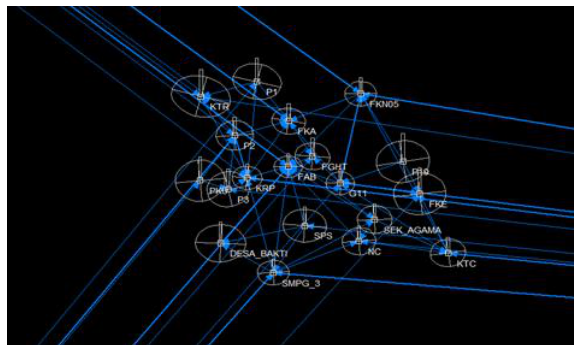
Figure 6. 3D control network for GNSS